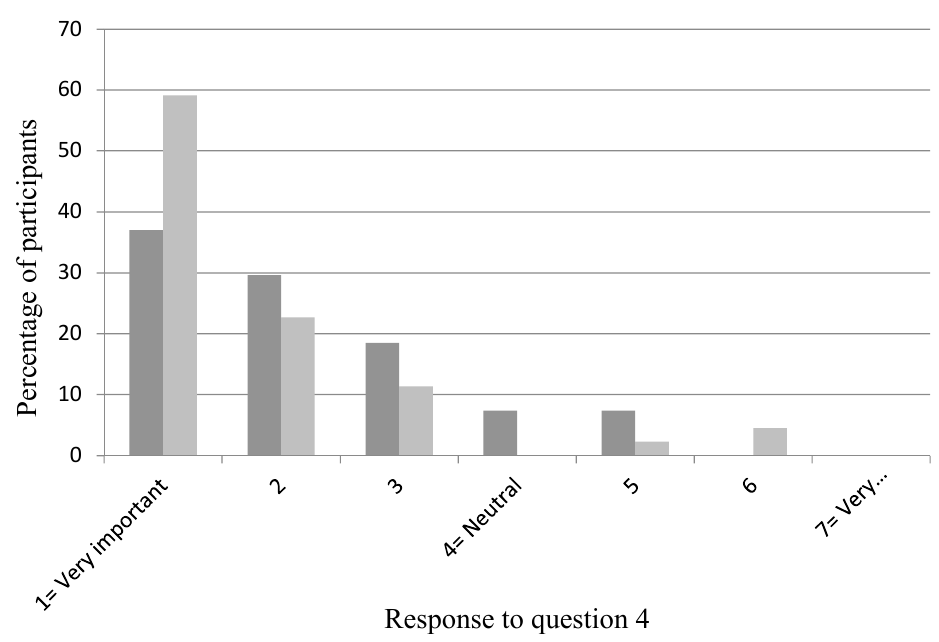
Table 3. Participants’ responses to Question 9: “Which of the following would best describe your response to an edentulous patient who in response to your advice about treatment options asks, “What would you do if you were me?”